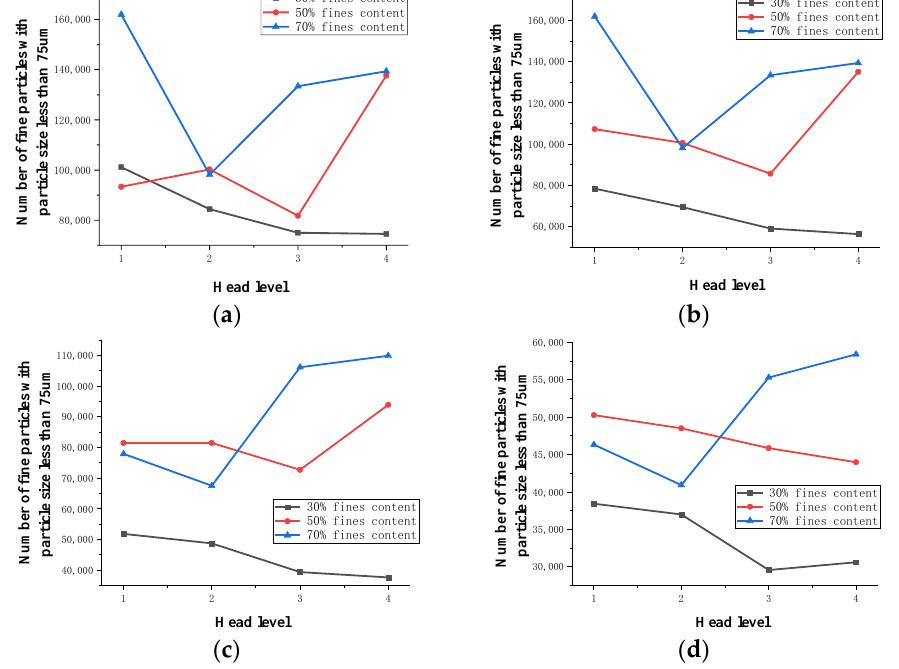
Figure 18. Variation in the particle number during infiltration with different fine contents. ( a ) Particle size: 0 – 10 µm; ( b ) Particle size: 10 – 20 µm; ( c ) Particle size: 20 – 40 µm; ( d ) Particle size: 40 – 75 µm.